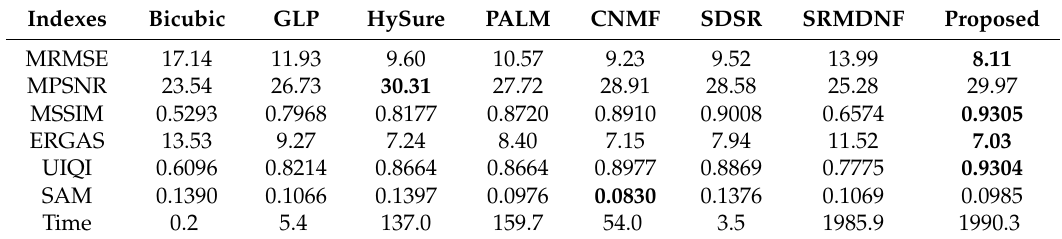
Table 2. Quantitative results on the Pavia dataset with a magnification factor of